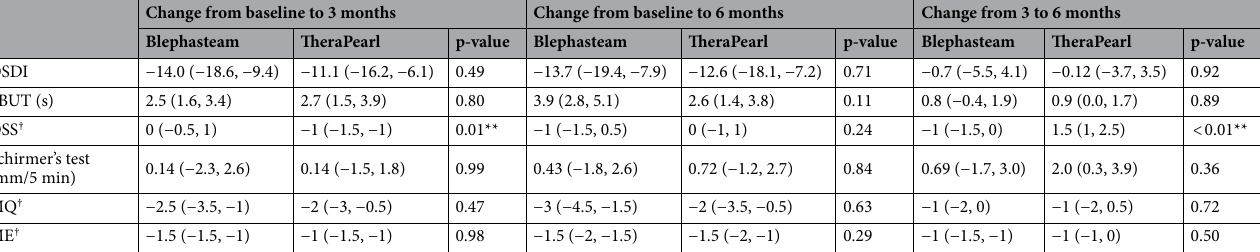
Table 3. Results of the analysis comparing efficacy between the treatments. Mean changes between time points were reported preceding 95% confidence intervals in parentheses. †Median changes were reported. **p < 0.05, the negative significant value indicates TheraPearl decreased OSS by 1 more than Blephasteam and vice versa at 6 months. OSDI ocular surface disease index measured on a scale from 0 to 100, FBUT fluorescein breakup time measured in seconds, OSS ocular surface staining scored with the Oxford grading scheme from 0 to 15 42 , MQ meibomian quality scored on a scale from 0 to 24, ME meibomian expressibility scored on a scale from 0 to 3.